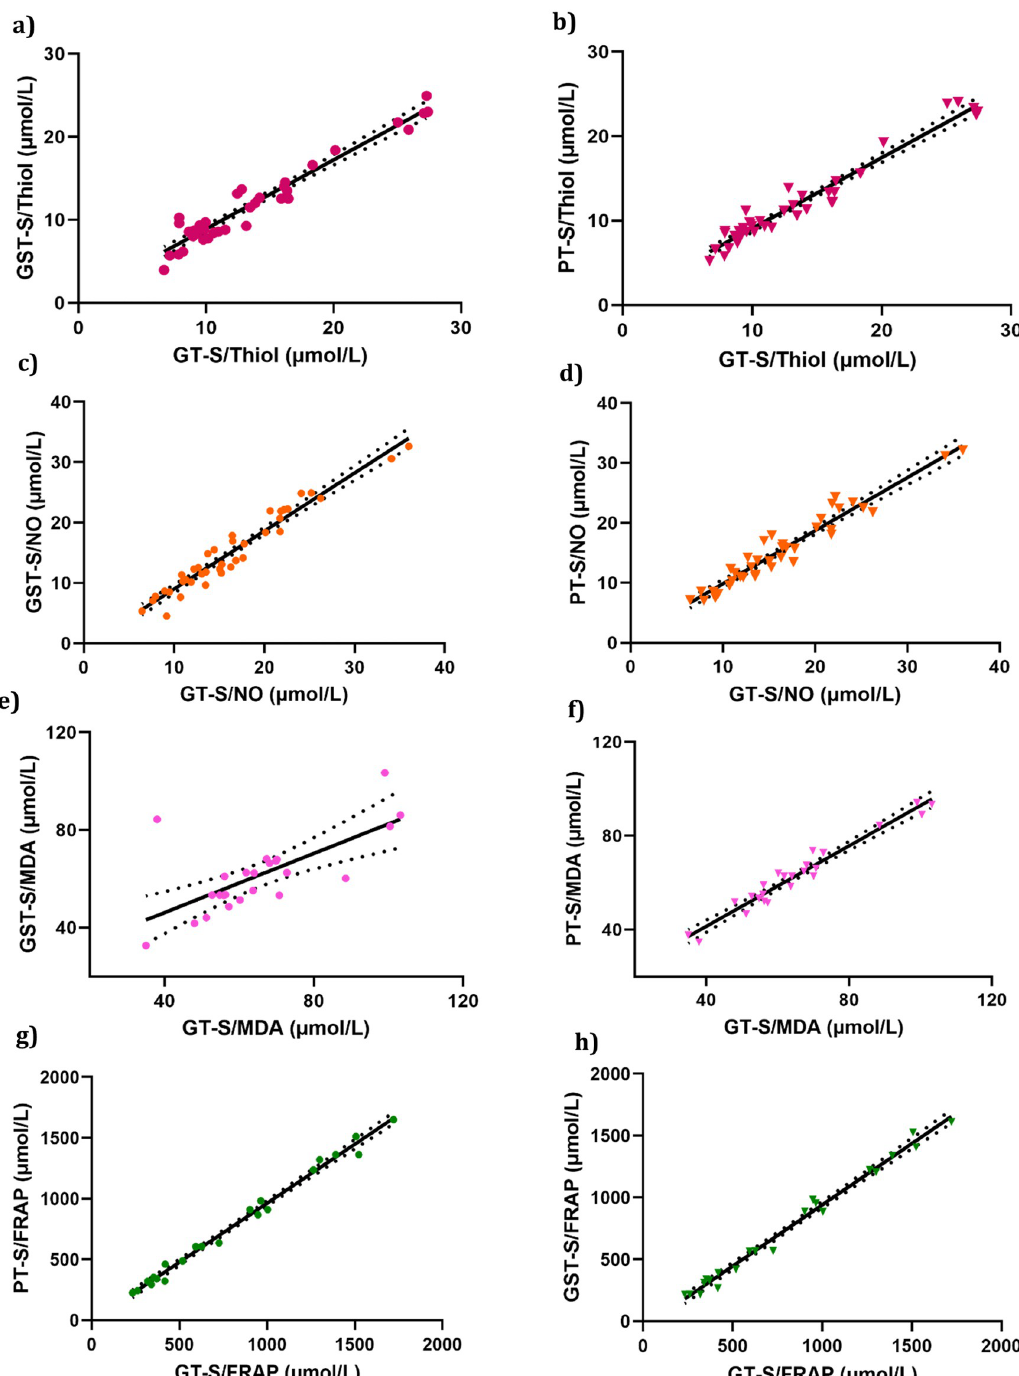
Fig 4. Comparison of assay results after collection of blood in PT, GT, and GST tubes, using passing and bablok regression analysis. Regression line (full line) with its 95% confidence interval (broken lines). Comparison of results for PT, GST and GT tubes for the antioxidants